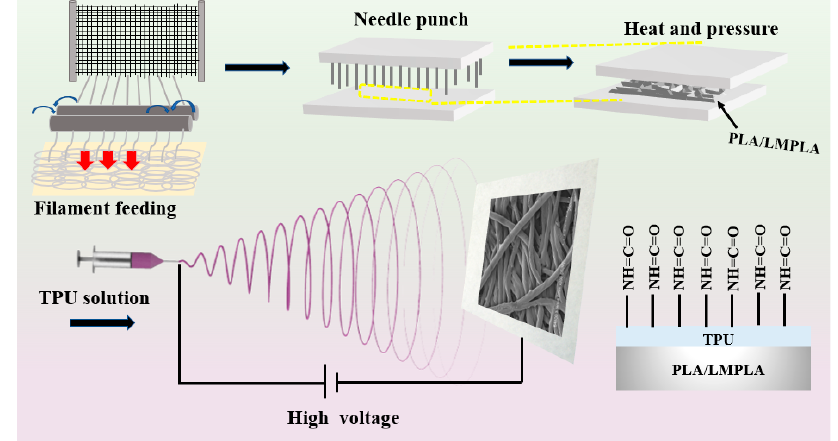
Figure 1. Preparation process of micro-/nano-composite membranes.